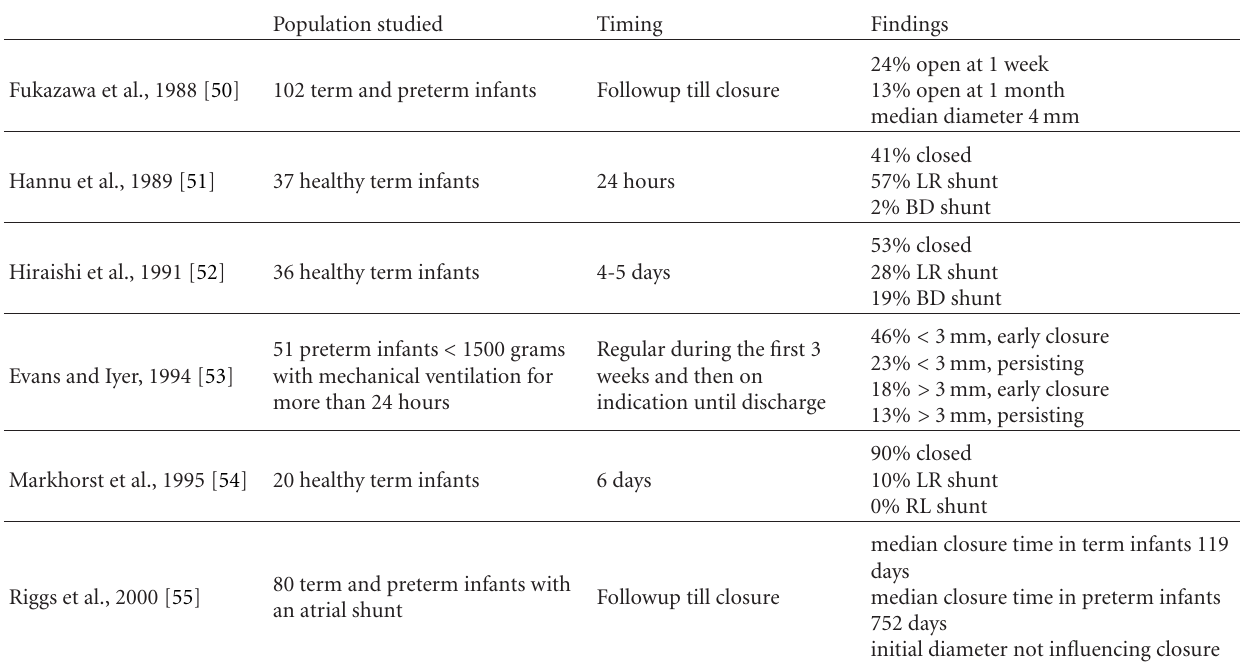
Table 5: Studies investigating atrial shunt in newborn